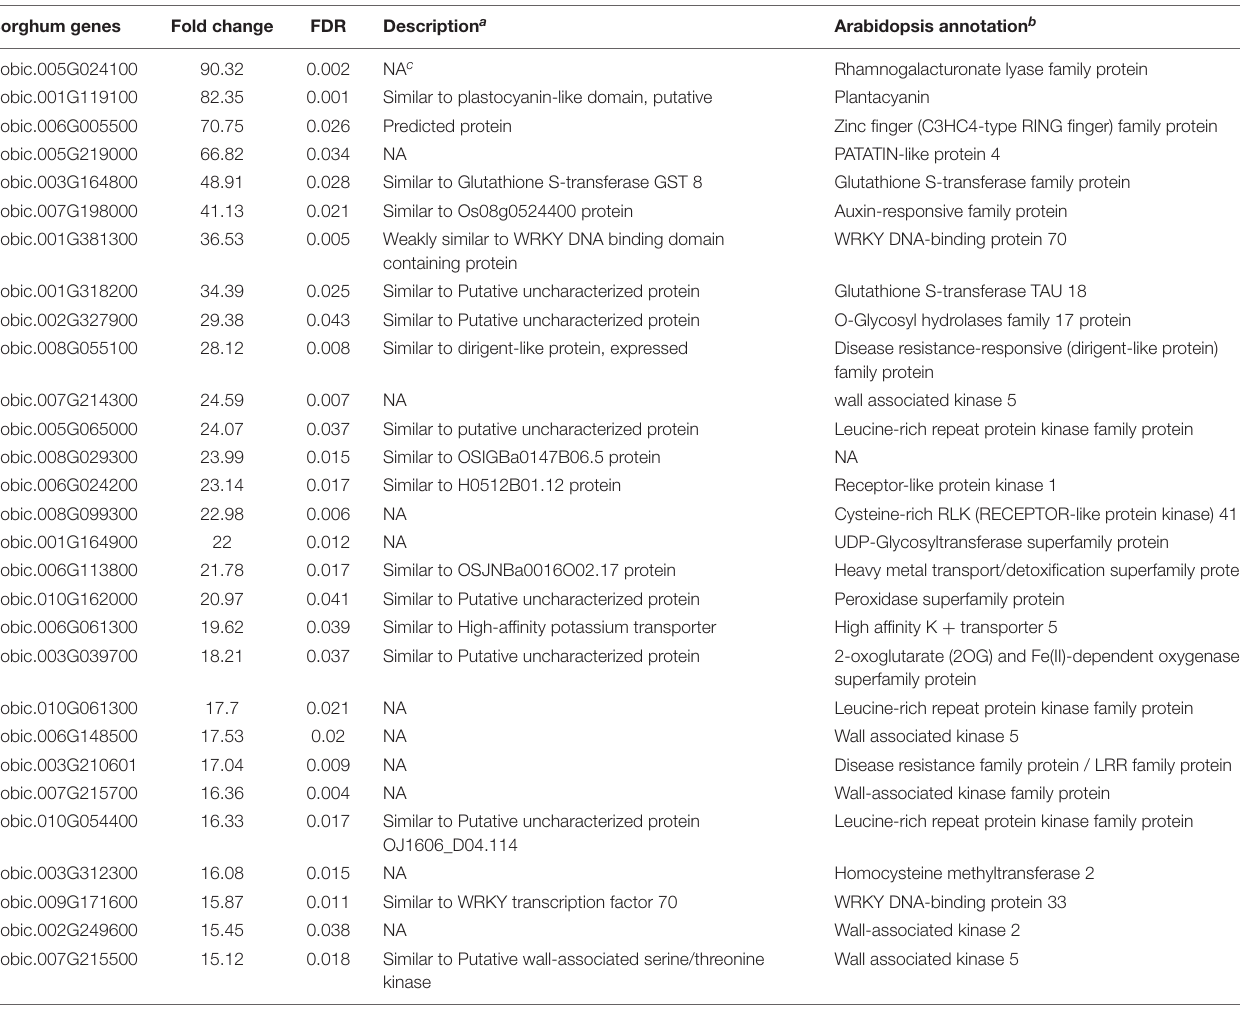
TABLE 3 | Differentially expressed genes related to defense and unique to the incompatible interaction at 72 hai in sorghum with fold change greater than 15 and FDR < 0.05. Sorghum genes Fold change